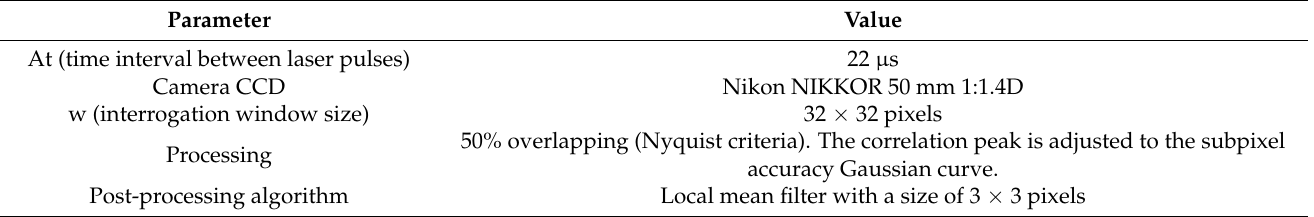
Table 3. Particle Image Velocimetry